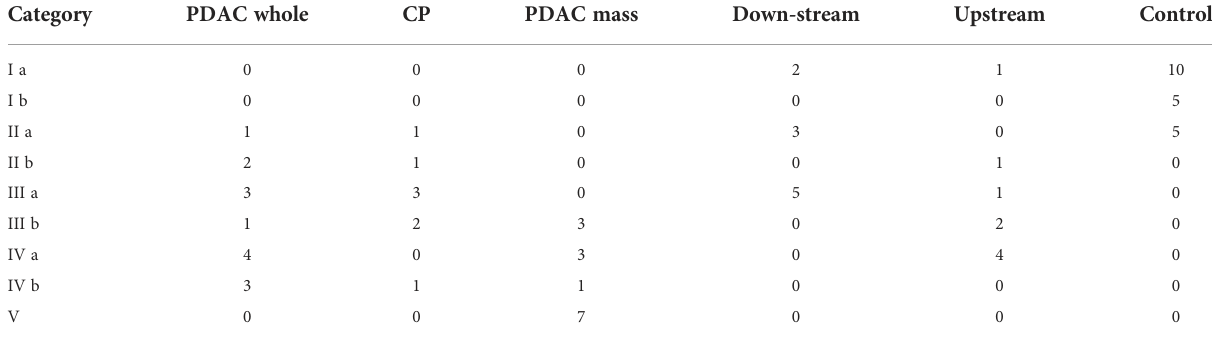
TIC, time-signal intensity curve.